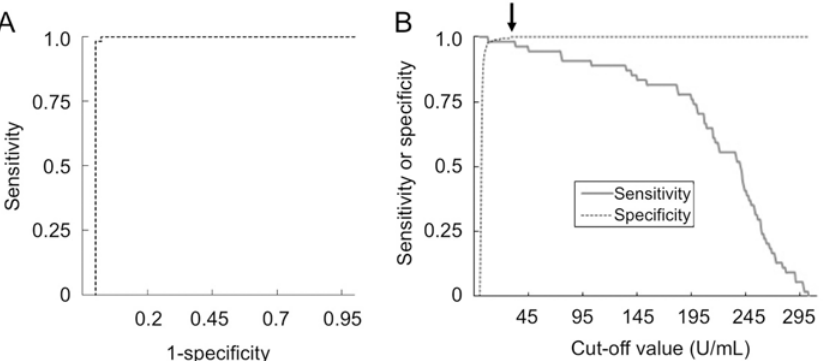
Fig 2. ROC curve analysis to determine the optimal cut-off value for ELISA-quantified anti-MDA5 antibodies. A. The ROC curve showed high concordance between the ELISA and IP assay (area under the curve > 0.99, P < 0.0001). B. The sensitivity and specificity of the anti-MDA5 antibody ELISA for various cutoff levels. A cutoff of 32 U/mL (arrow) provided a sensitivity of 98.2% and specificity of